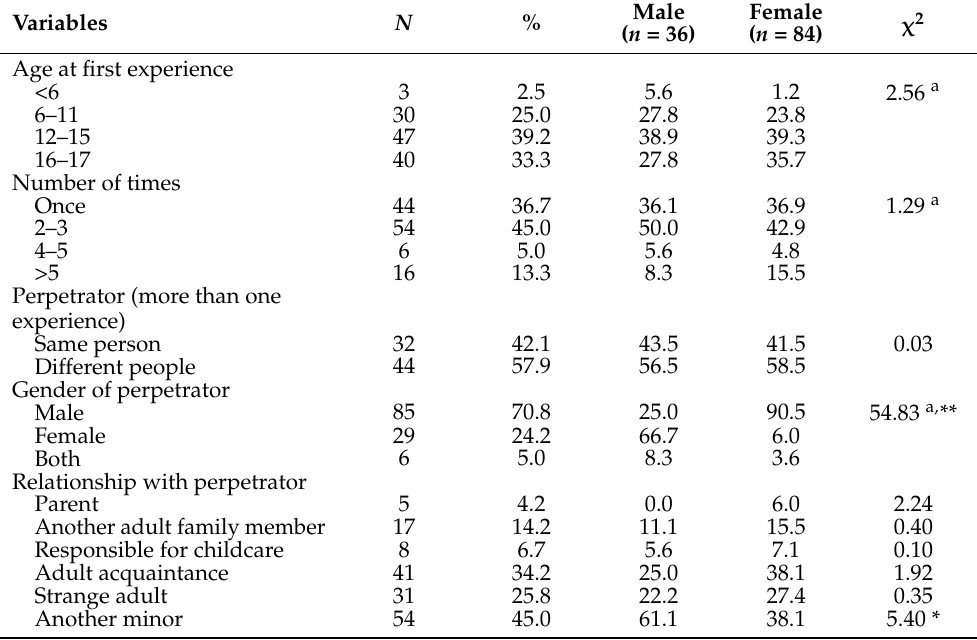
Table 5. Percentage of victims’ age at the first experience and perpetrator’s characteristics as a function of gender for “somebody kissed